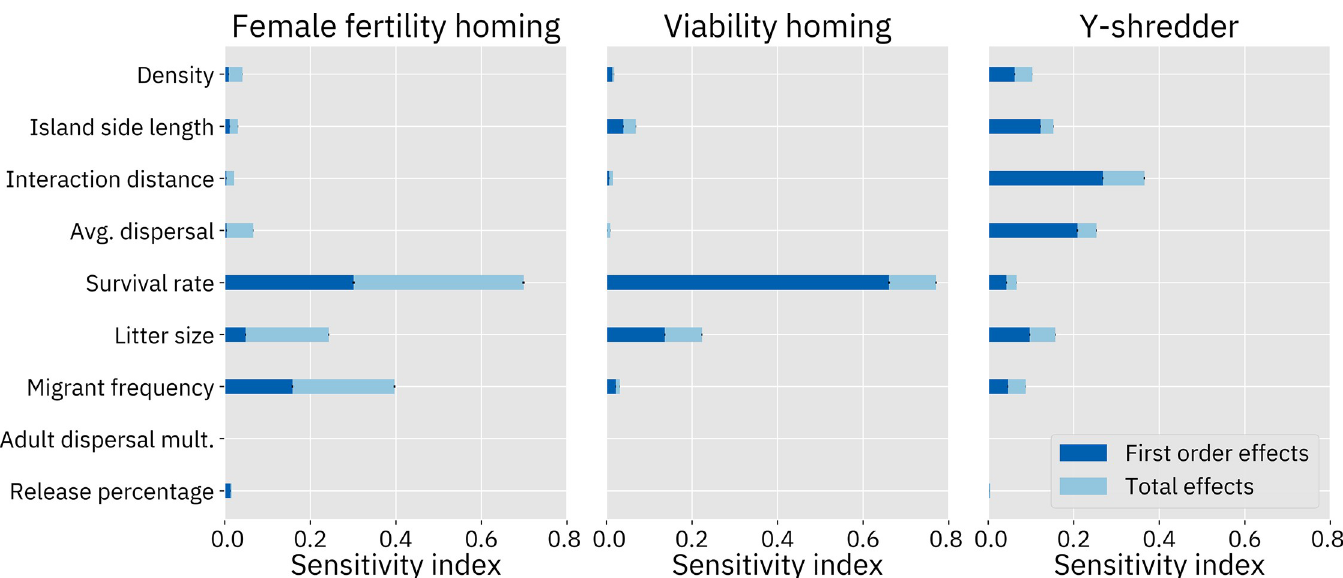
Fig 9. Sobol sensitivity analysis with fixed fitness and efficiency. For the female fertility homing drive, fitness and efficiency were both fixed at 90%. For the viability homing drive, fitness and efficiency were both fixed at 97%. For the Y-shredder, fitness and efficiency were both fixed at 99%. The models without resistance were used. “First order effects” describe the effects of varying a single parameter. “Total effects” include the first order effects of the parameter, as well as potential synergistic interactions between that parameter and one or more other